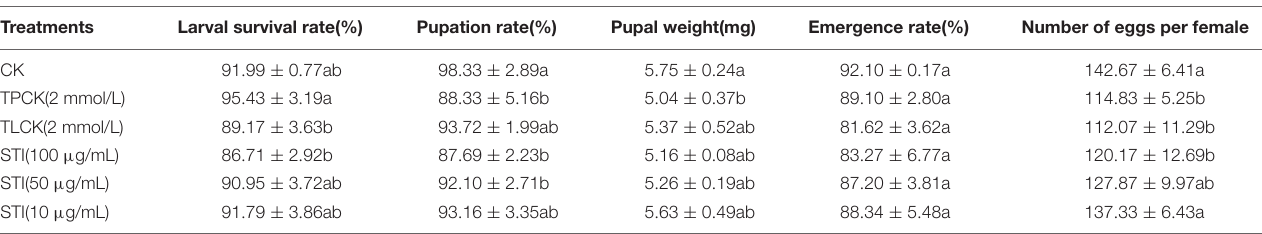
TABLE 2 | Effects of ingesting different protease inhibitors on growth and development of Plutella xylostella . Treatments Larval survival